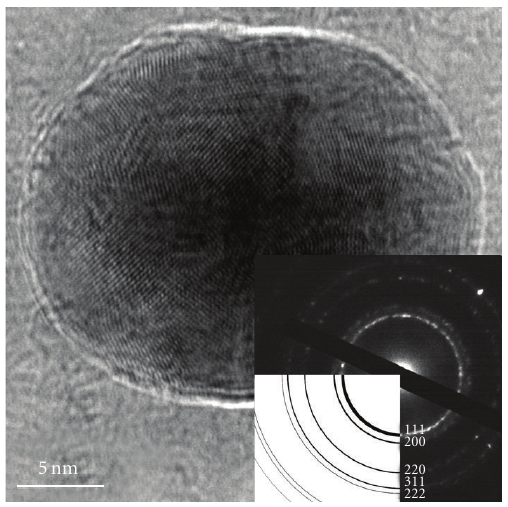
Figure 4: In situ HRTEM image of a silver nanoparticle taken at 500 ◦ C in vacuum. Inset: In situ SAED pattern of the nanoparticle taken at 500 ◦